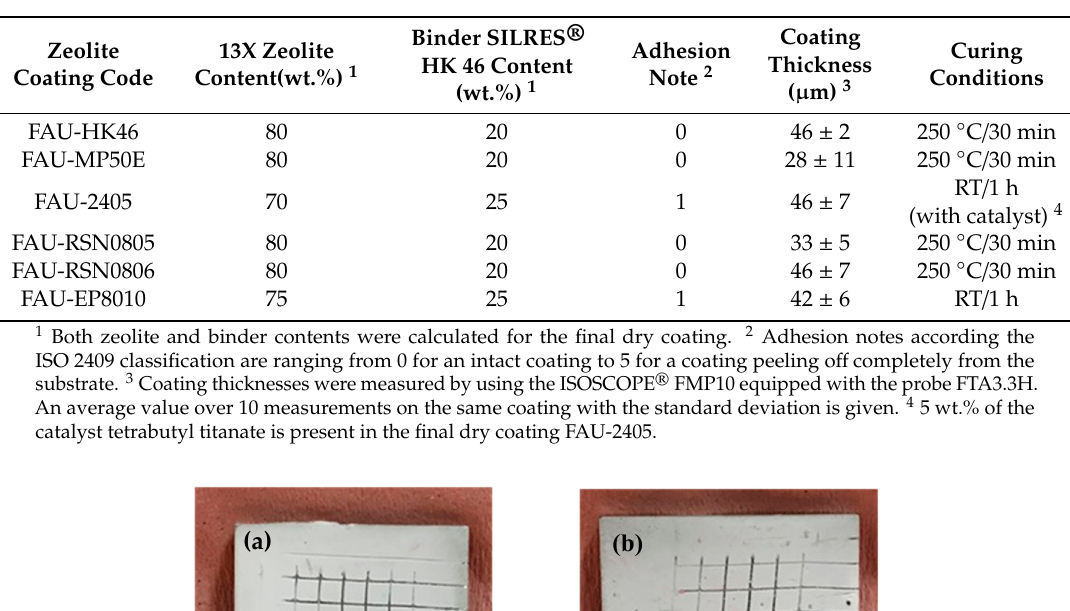
Table 3. Composition, adhesion note, coating thickness and curing conditions of zeolite coatings.